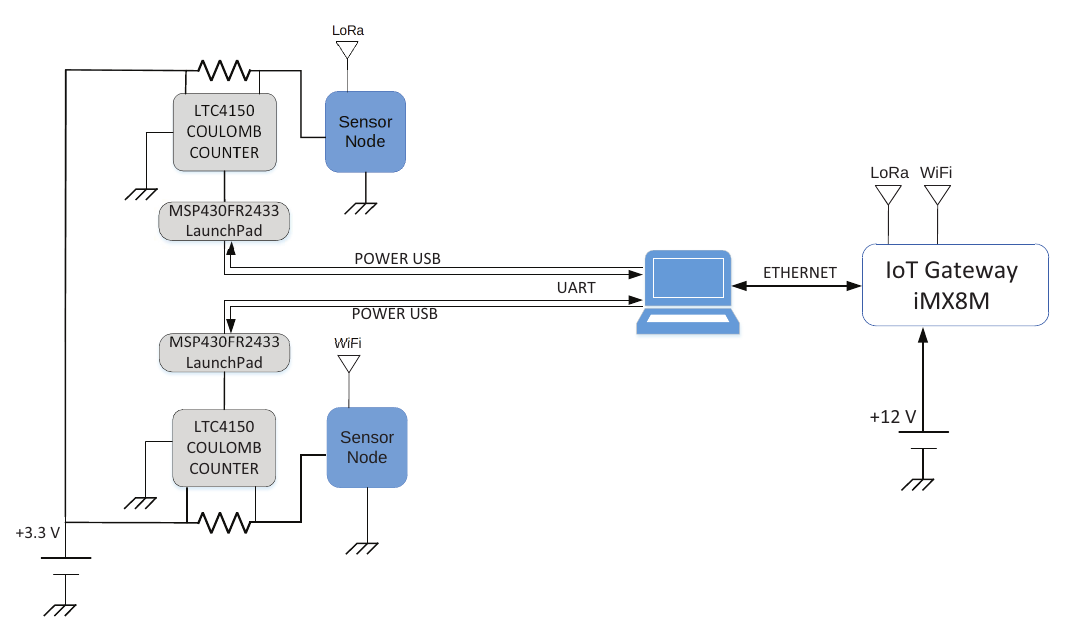
Figure 9. Implemented setup for the energy consumption measurements. As can be seen in the photogragh of Figure 10, the msp430FR2433 LaunchPad is powered from the PC through the USB connector, whereas the power supply is used to power the sensor nodes and the Coulomb counter at 3.3 V. The LoRa and WiFi gateway have been both implemented in the same Variscite DART-MX8M SOM. A motherboard is used to connect and power the SOM.